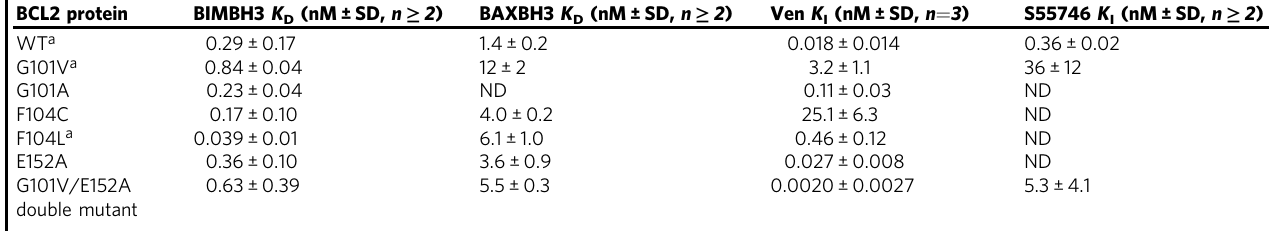
Table 2 SPR af fi nity values for BH3 peptides and BCL-2 selective compounds binding to BCL-2 mutants BCL2 protein